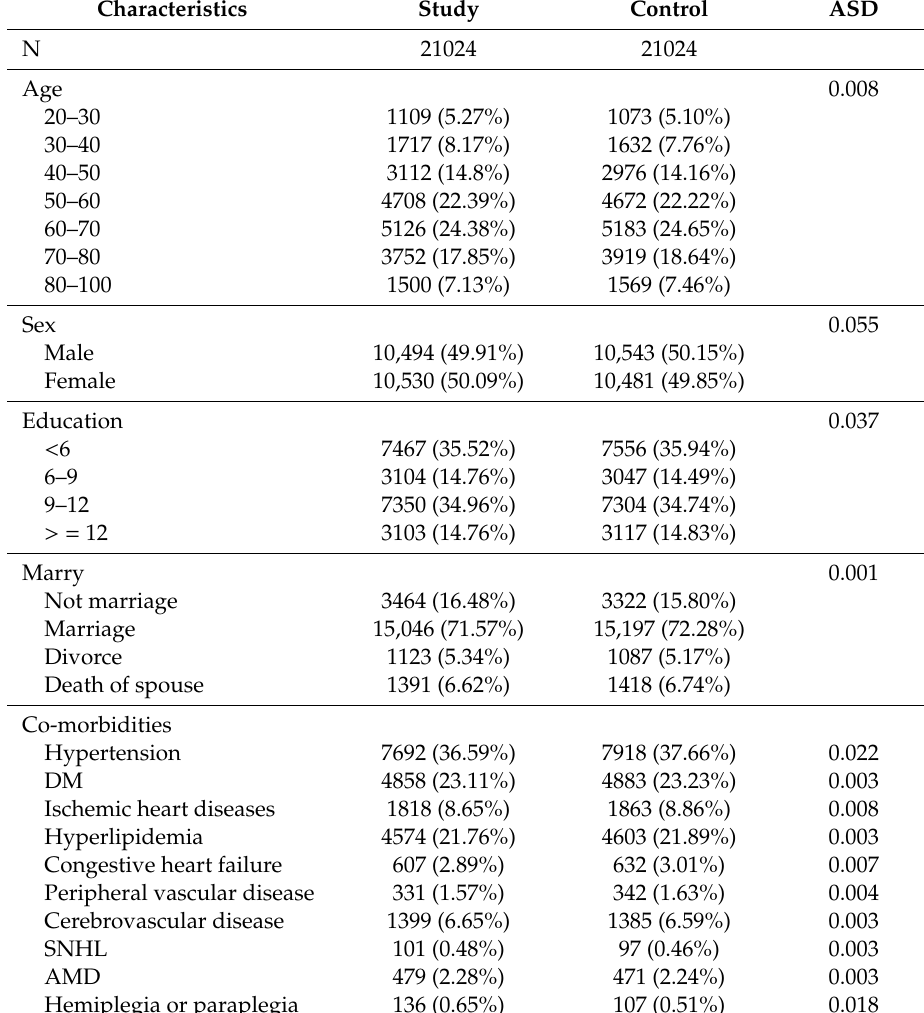
Table 1. Characteristics among study cohorts in 1:1 propensity score-matching